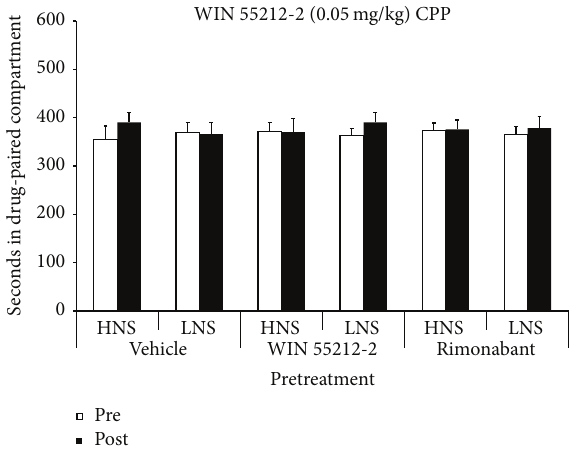
Figure4:EffectsofWIN55212-2(0.05 mg/kg)ontheCPPparadigm in HNS and LNS adolescent mice pretreated 6 days before initiation of conditioning with vehicle (HNS, 𝑛 = 12 ; LNS, 𝑛 = 13 ), 0.1mg/kg of WIN 55212-2 (HNS, 𝑛 = 12 ; LNS, 𝑛 = 13 ), or 1mg/kg of rimonabant (HNS, 𝑛 = 14 ; LNS, 𝑛 = 15 ). Bars represent time in seconds spent in the drug-paired compartment during preconditioning (white) and postconditioning (black).